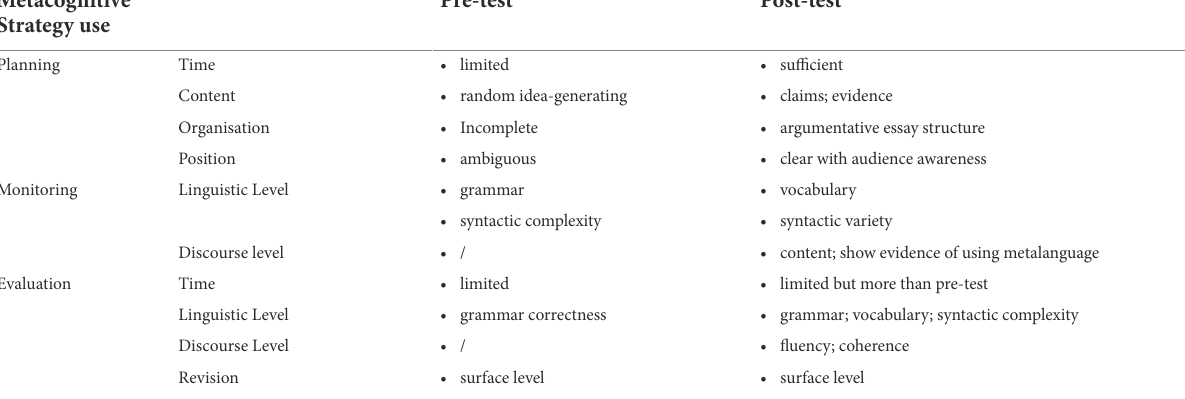
TABLE 4 Jiaqi’s metacognitive strategy development trajectory. Metacognitive Strategy